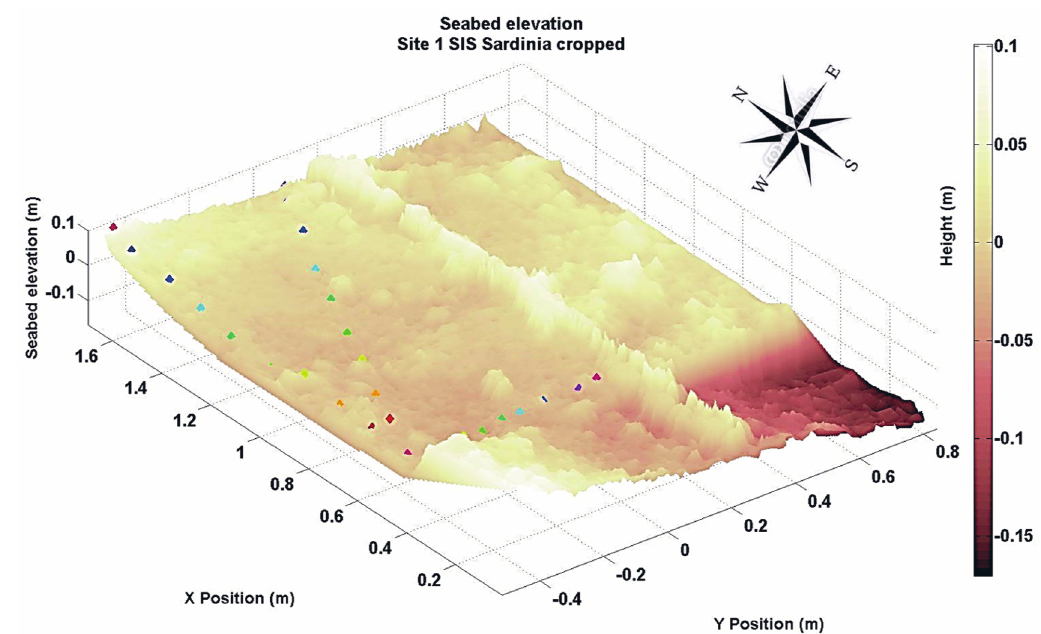
Figure 5. An example of the raw bed roughness from BRAD at station 1. The rectangular subsections of the bed where the topographical bed roughness is estimated are shown by the multi-colored dots in the figure.